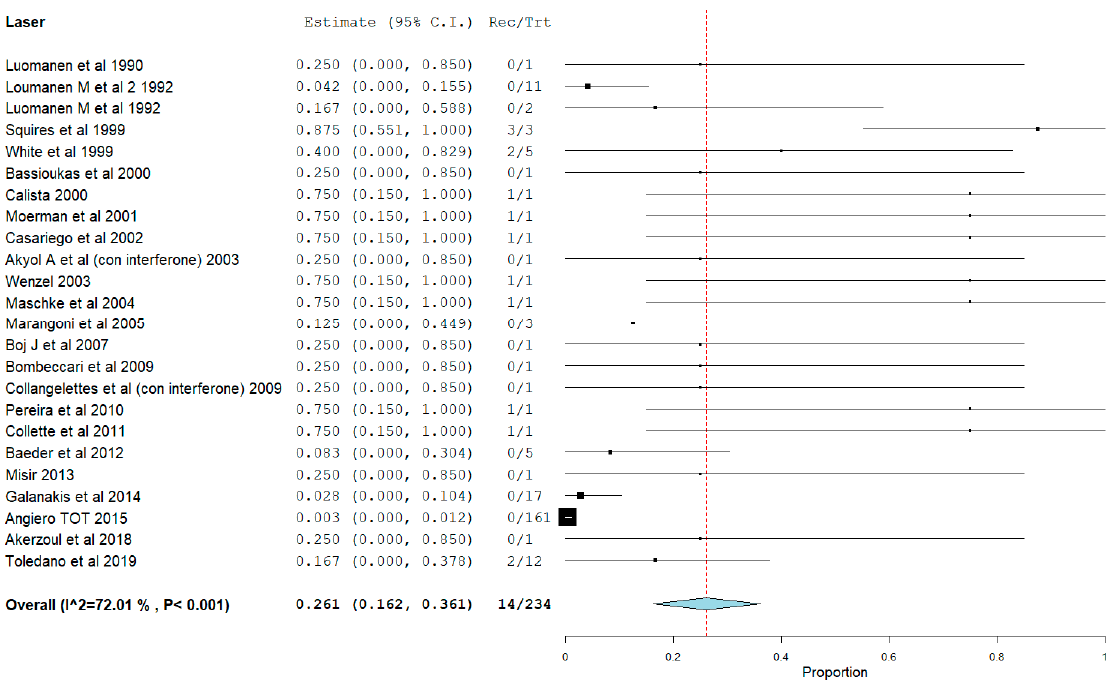
Figure 3. Forest-plot, laser excision studies.